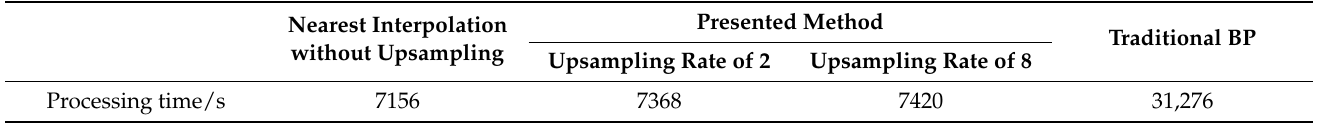
Table 4. Processing time of different focusing